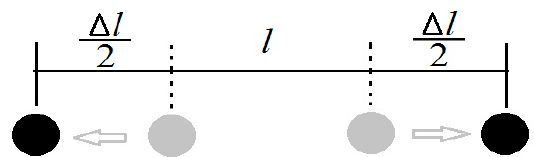
Figure 6. Definition of dimensionless amplitude h = Δ l/L.